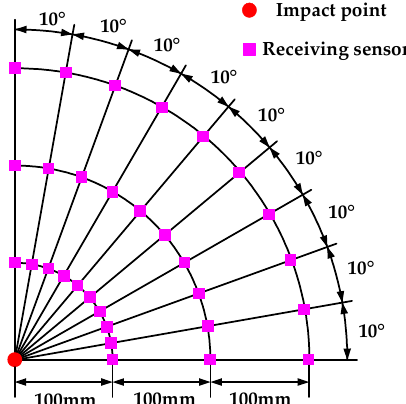
Figure 9. The schematic diagram of wave velocity measurement experiment.